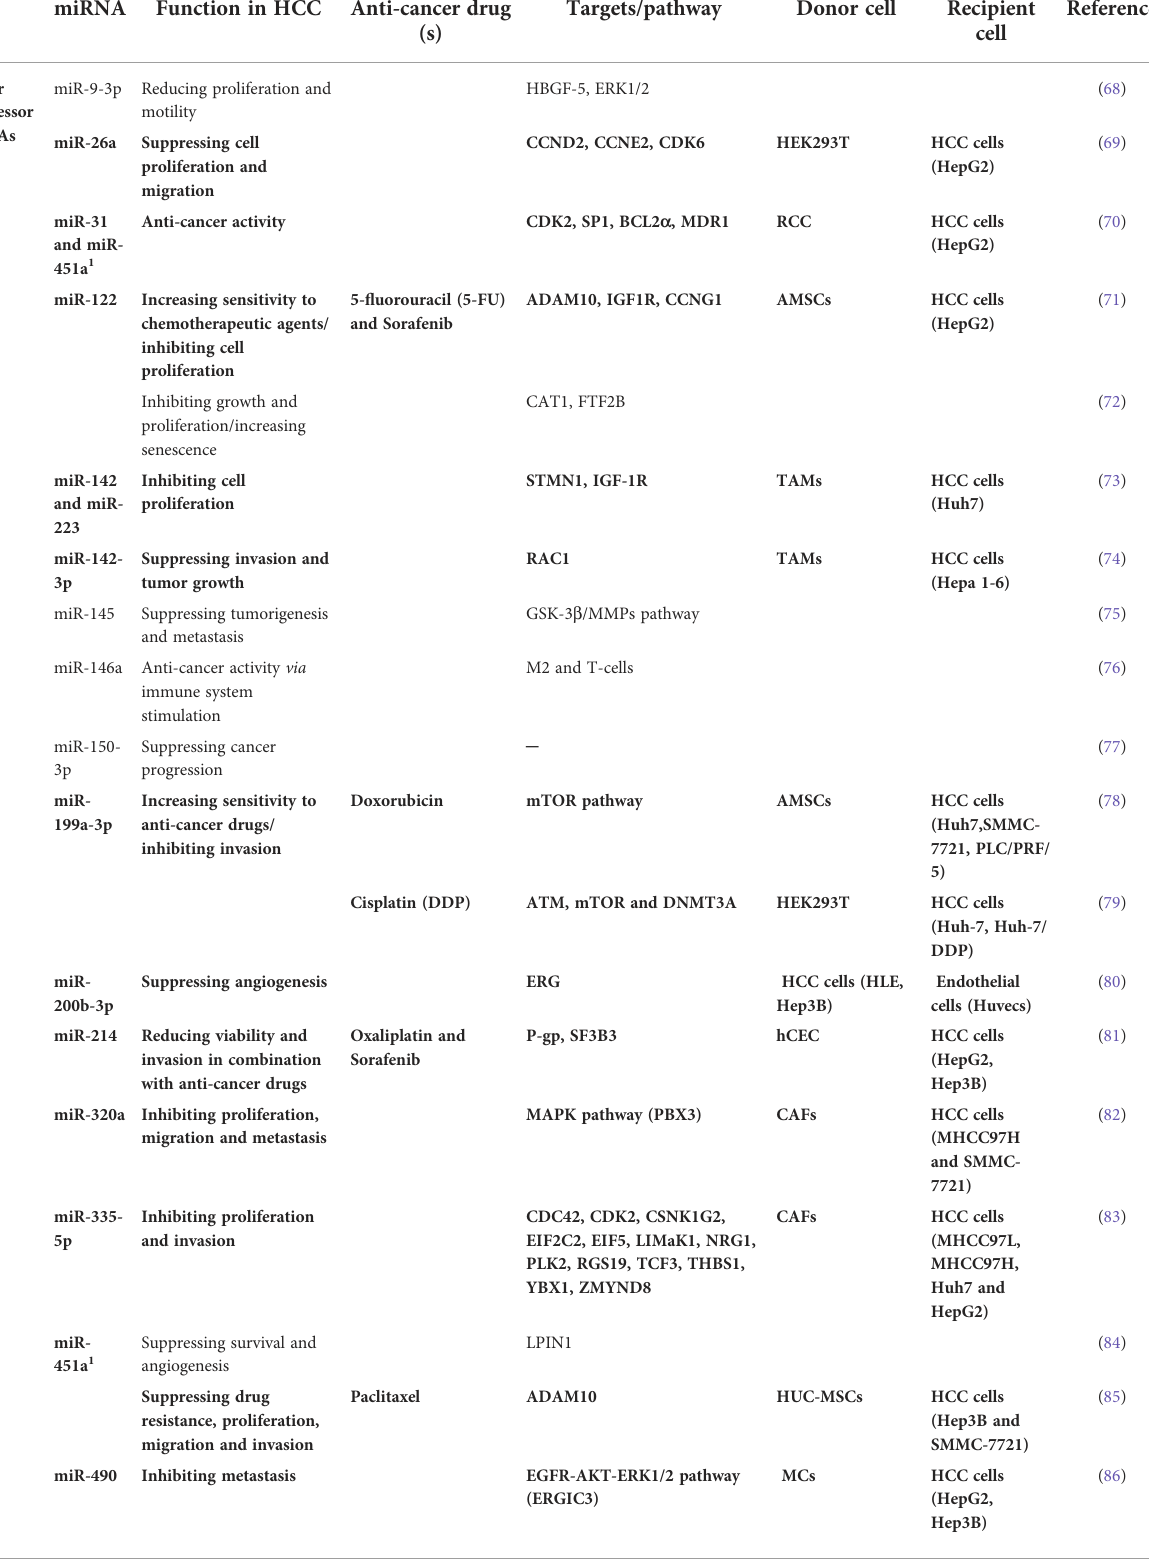
TABLE 1 Overview of exosomal miRNAs involved in HCC pathogenesis.